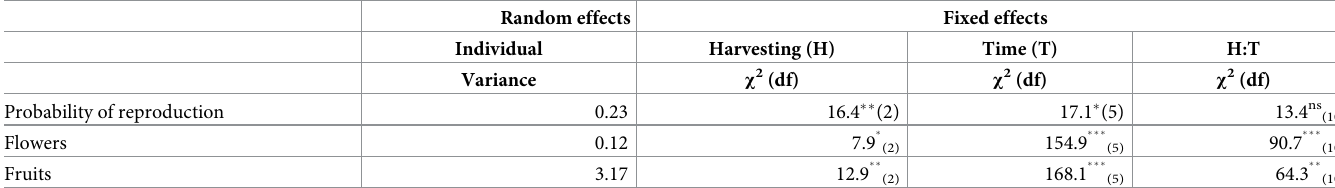
Table 2. Results of the statistical analyses on reproductive traits to evaluate the effects of chronic defoliation on Brahea aculeata in the tropical dry forest of A´la- mos,